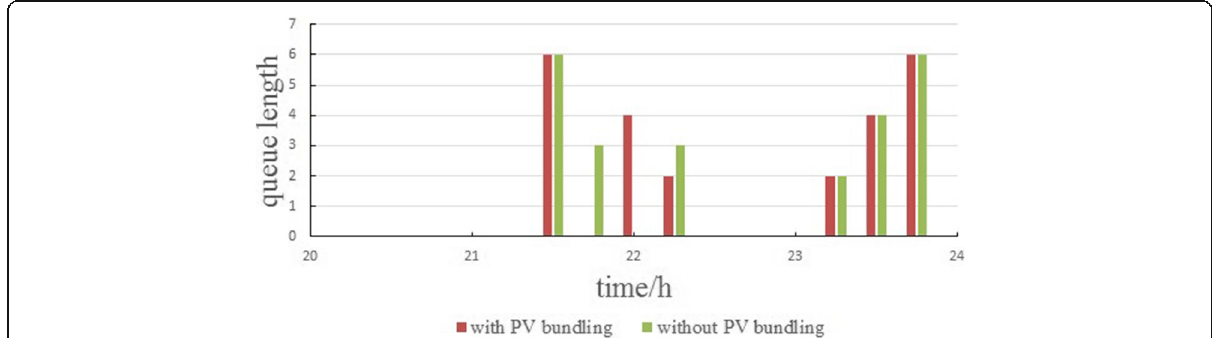
Fig. 6 Waiting queue lengths with and without PV bundling requirements at a workday in the Summer